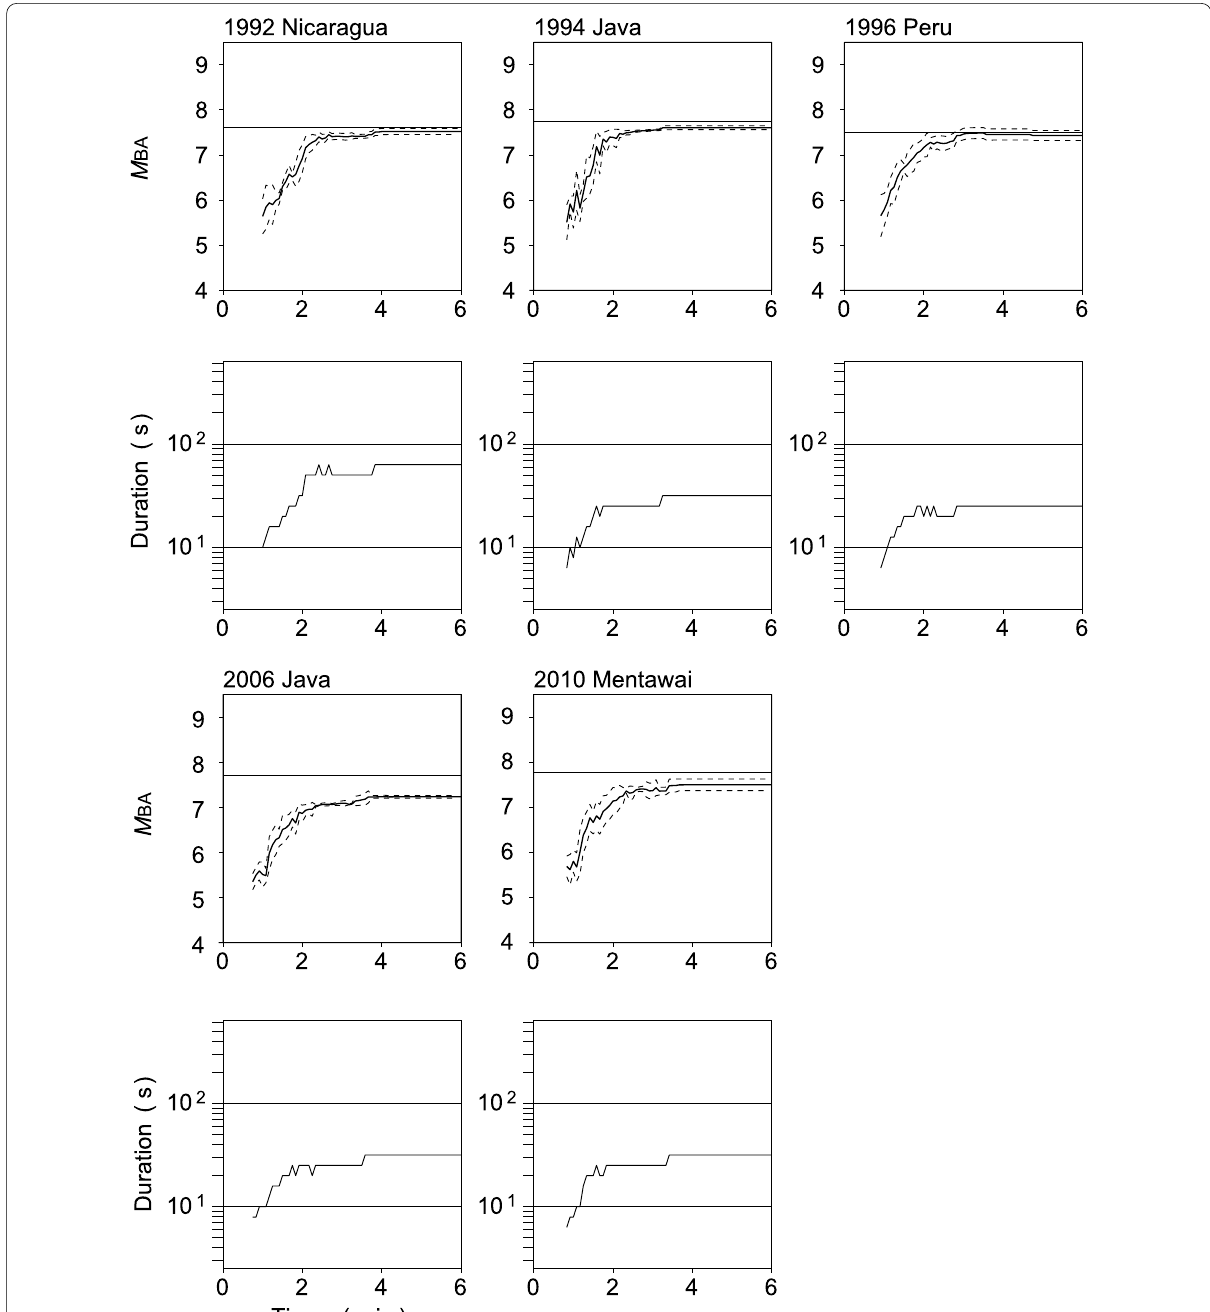
Fig. 11 Variations of the estimated magnitude ( M BA ) (upper graph) and duration (lower graph) in relation to elapsed time from the origin for simulated data of five tsunami earthquakes (see Fig. 8). On the magnitude graphs, the horizontal solid line indicates M w , and dashed lines show ± standard deviation of the estimated station magnitudes